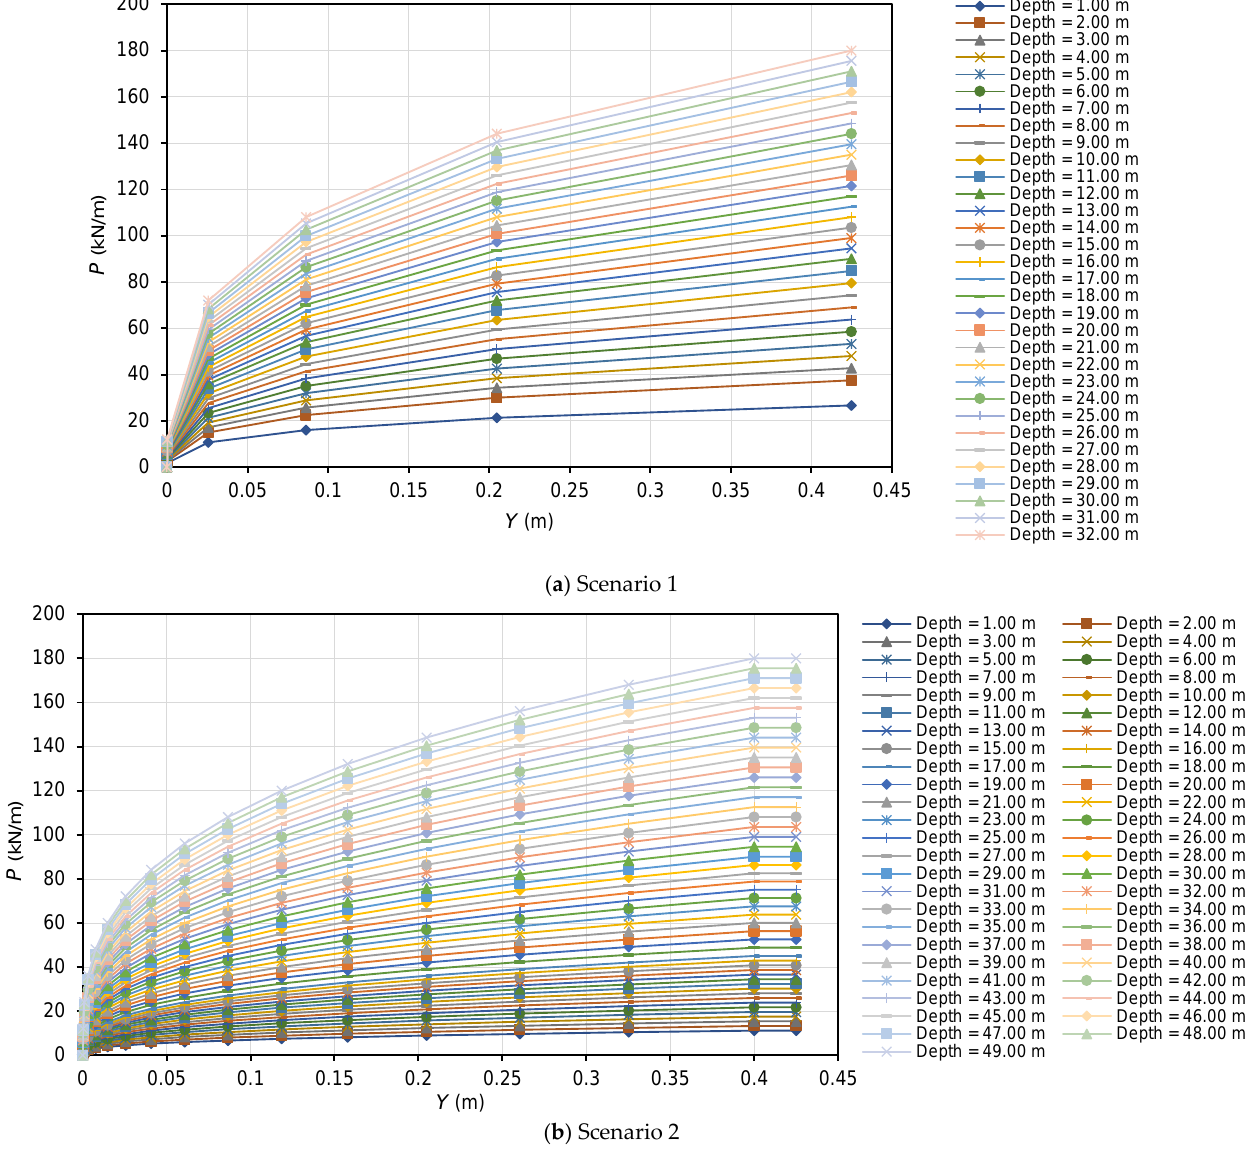
Figure 6. P-Y curves for Pile 1 (Ø 1000 mm).